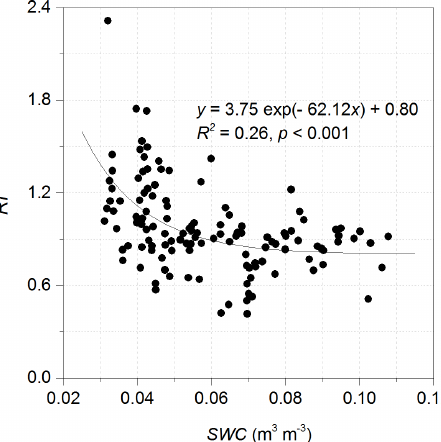
Figure 5. Time lags between measured and modeled soil respiration by means of soil-surface temperature and photosynthesis over the growing season; R s − T function (Eq. 1), R s − P function (Eq. 2), and R s − P − T function (Eq.